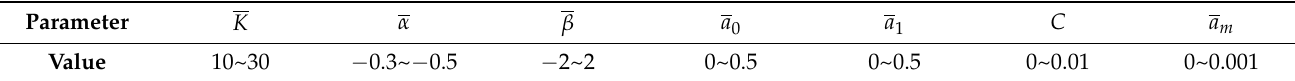
Table 2. Dimensionless